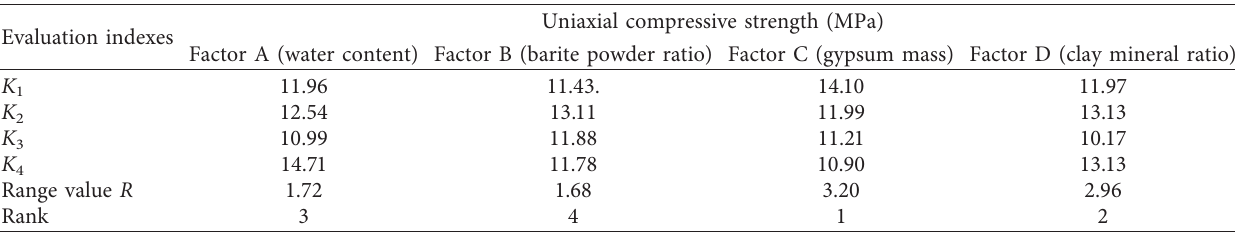
Table 10: Range analysis of uniaxial compressive strength.